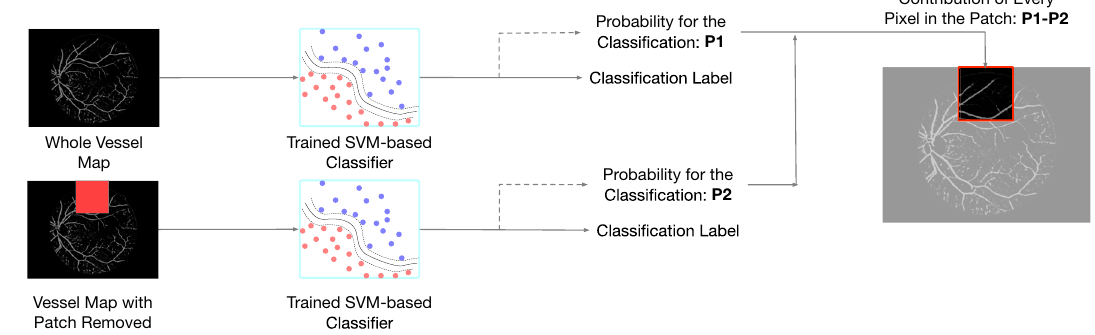
Figure 6. Occlusion tests were used to generate saliency maps in this study. The occlusion test measures the importance of a certain area for the predicted label by measuring the probabilities of the target classification label with and without this area in the image (Method).